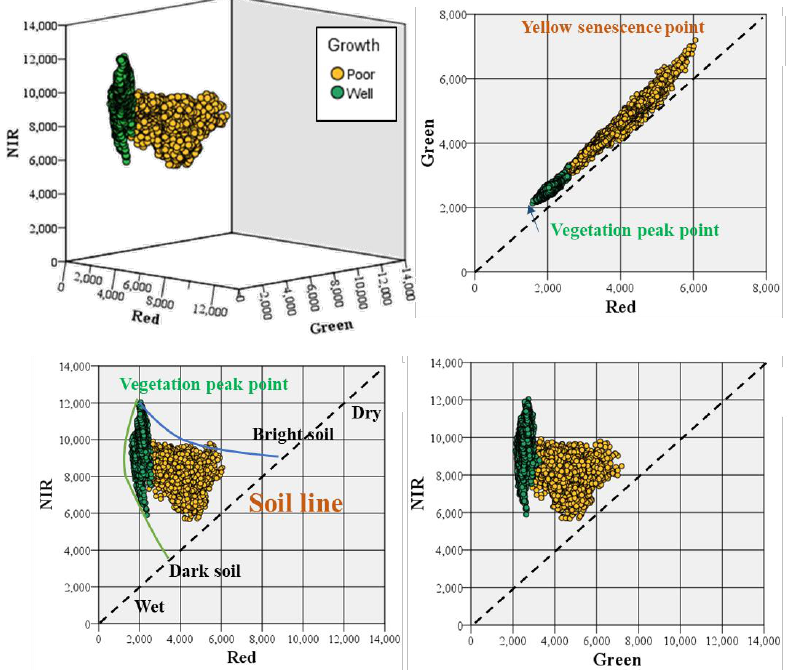
Figure 9. Three-dimensional distribution of green, red, and near-infrared wavelengths of healthy and unhealthy cabbages and the correlation of each band identified by the UAV imaging sensor.